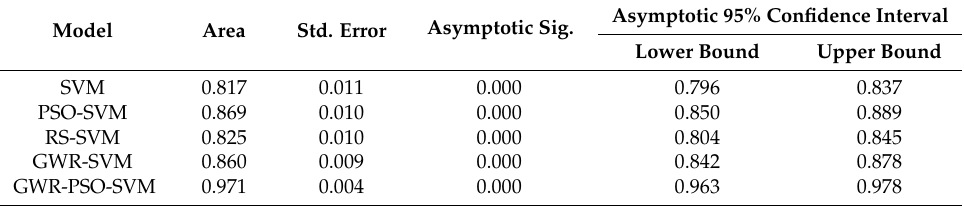
Table 11. The AUC of four